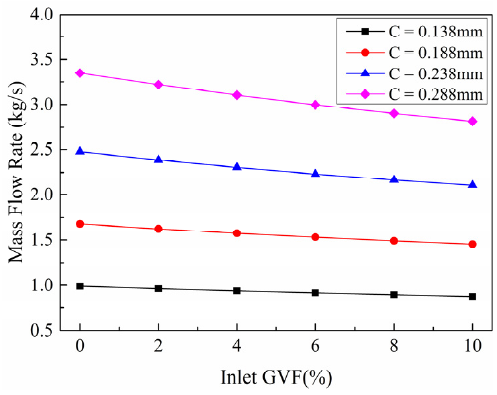
Figure 12. Seal leakage (mass flow rate) of model seals with different clearances versus inlet GVF under the conditions of Δ P = 48.3 bars.